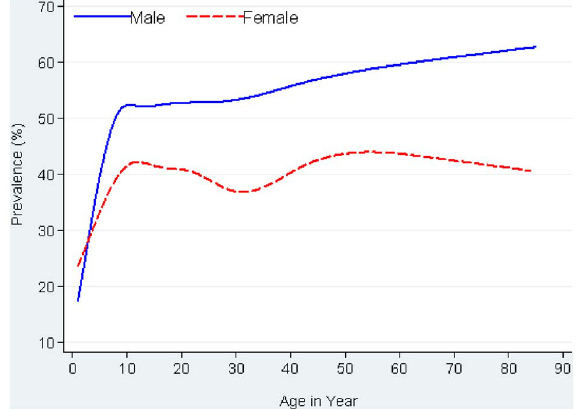
Figure 2. Smoothed age prevalence of S.stercoralis infection by sex among 2,396 participants in Preah Vihear province, Cambodia, 2010.